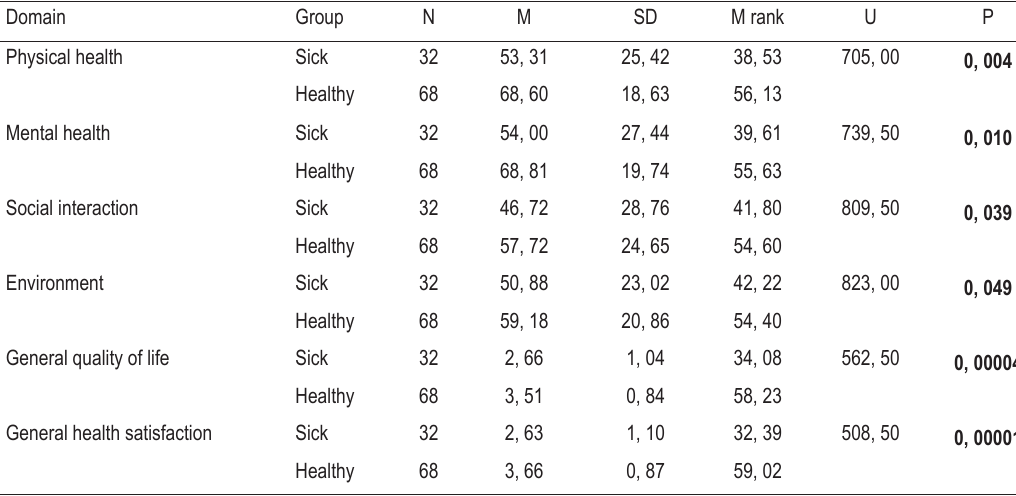
TABLE 5. Quality of life of mothers in relation to the presence of a health problem